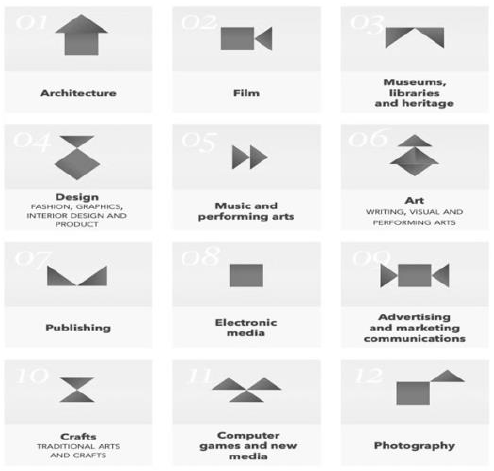
Figure 1: Creative industry sectors in the Republic of Croatia; Source: Horvat, Mijoč, Zrnić